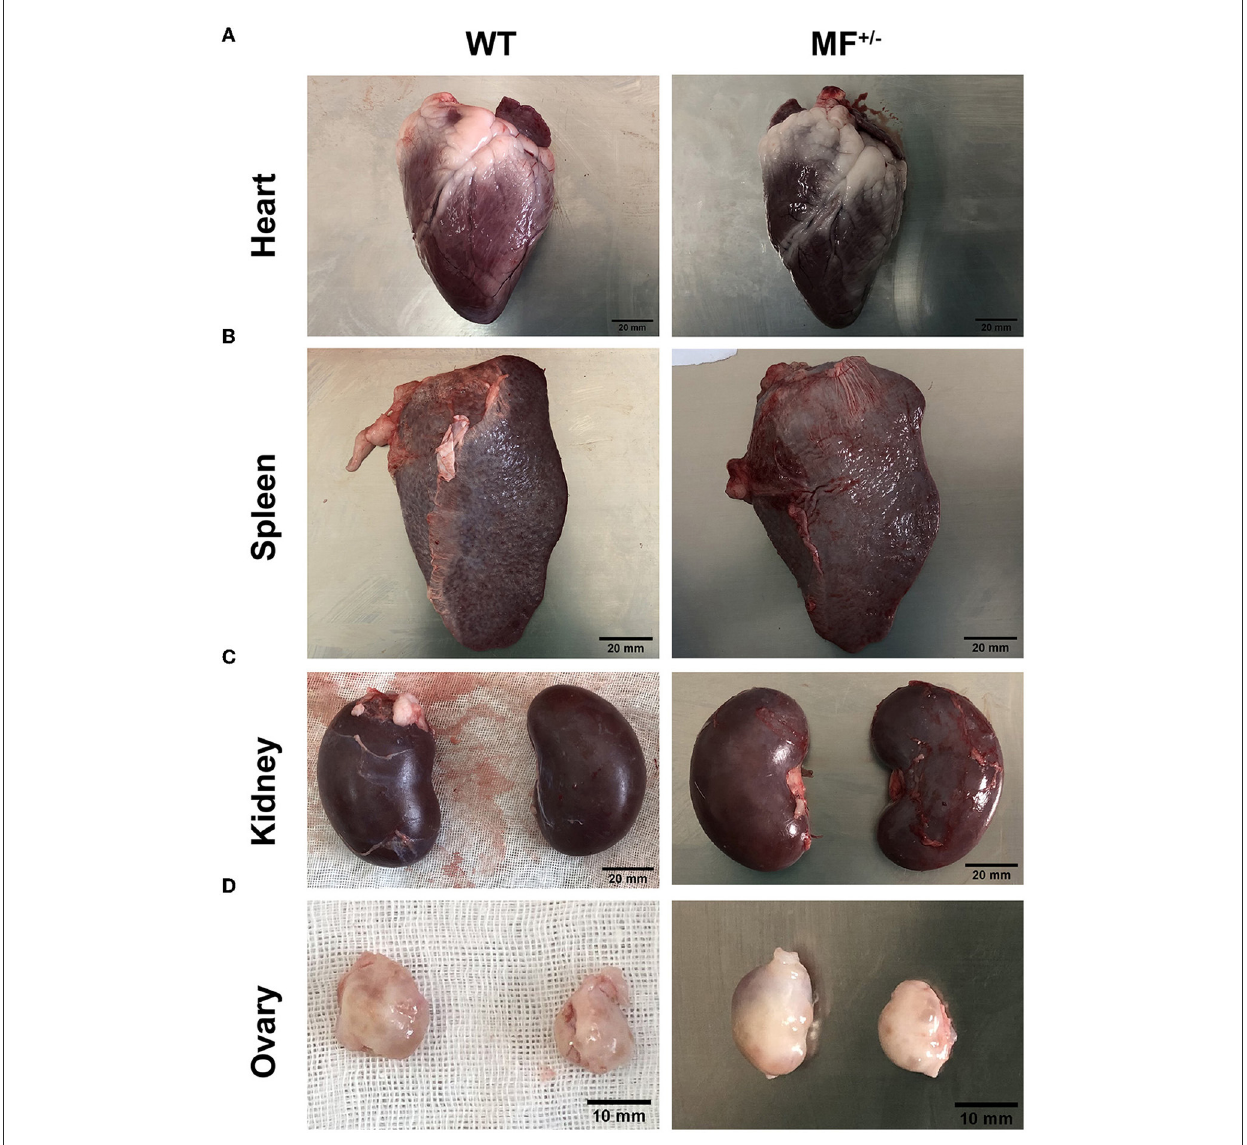
FIGURE2 Morphological analysis of heart, spleen, kidney and ovary in WT and MF +/- sheep. (A–C) Morphology of heart (A) , spleen (B) , and kindey (C) in 12-month-old WT and MF +/– sheep. Scale bar 20mm. (D) Morphology of ovary in 12-month-old WT and MF +/– sheep. Scale bar 10mm.